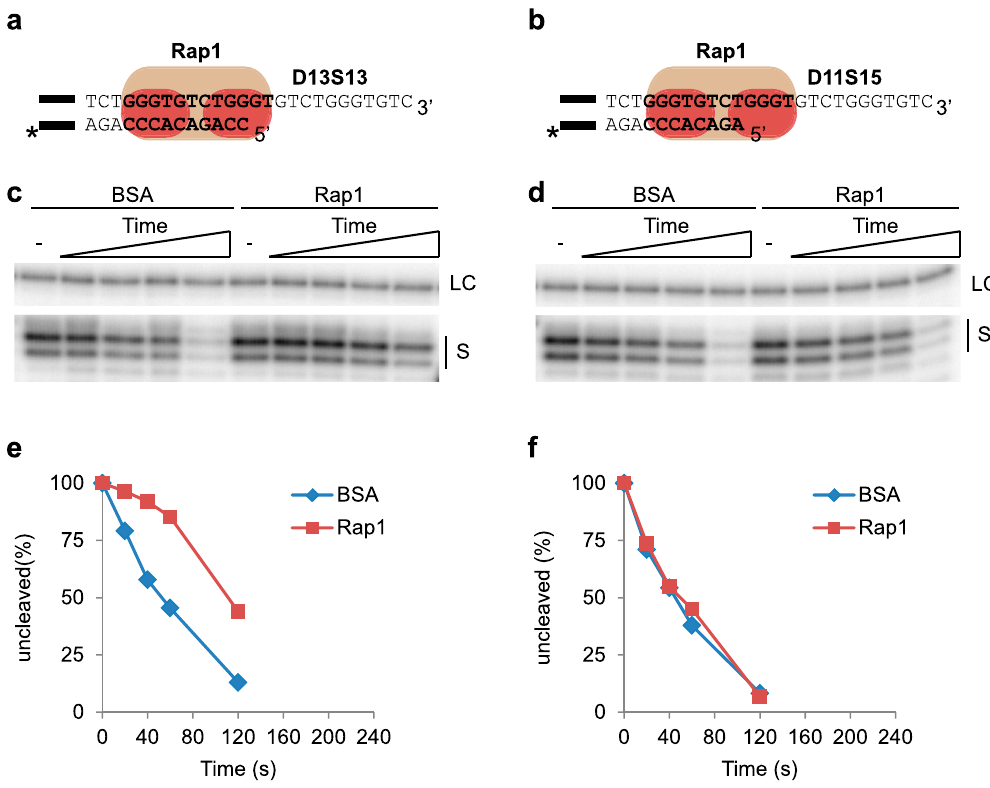
Figure 7. Rap1 protects the 5 ′ end when its binding site contains 2 nt but not 4 nt of ssDNA. ( a ) Telomere part of D13S13 contains 13 bp dsDNA and a 13 nt 3 ′ overhang. The Rap1 MBS (bold text) is located across the ds-ss junction and contains 2 nt of ssDNA. ( b ) D11S15 telomere part has 11 bp dsDNA and a 15 nt 3 ′ overhang. The Rap1 MBS locates across the ds-ss junction and contains 4 nt of ssDNA. The black bar indicates the guide sequence, and “ * ” the radioactive label (as described in Fig. 2 legend). ( c, d ) DEPA gels showing the results from D13S13 ( c ) and D11S15 ( d ). Both ( c ) and ( d ) show the loading control (LC) and uncleaved substrate (S) from the Rap1 containing and BSA control reactions at 0; 20; 40; 60; 120 s. Uncropped gels can be found in Supplementary Fig. S4. ( e,f ) Quantification of gels shown in ( c ) and ( d ) respectively.